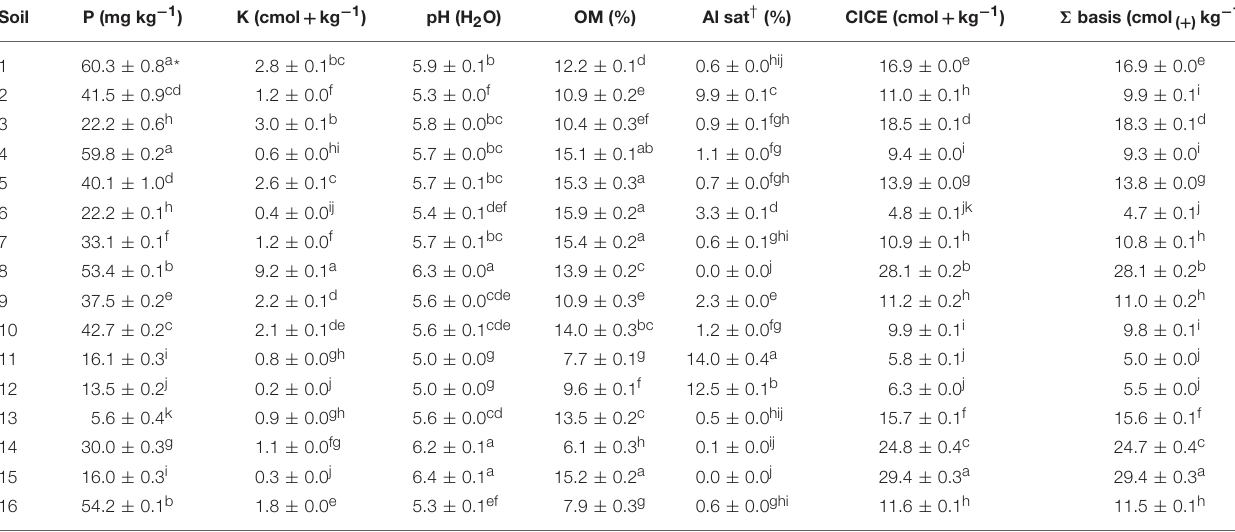
TABLE 2 | Average values for some chemical properties of rhizosphere soils used in this study.